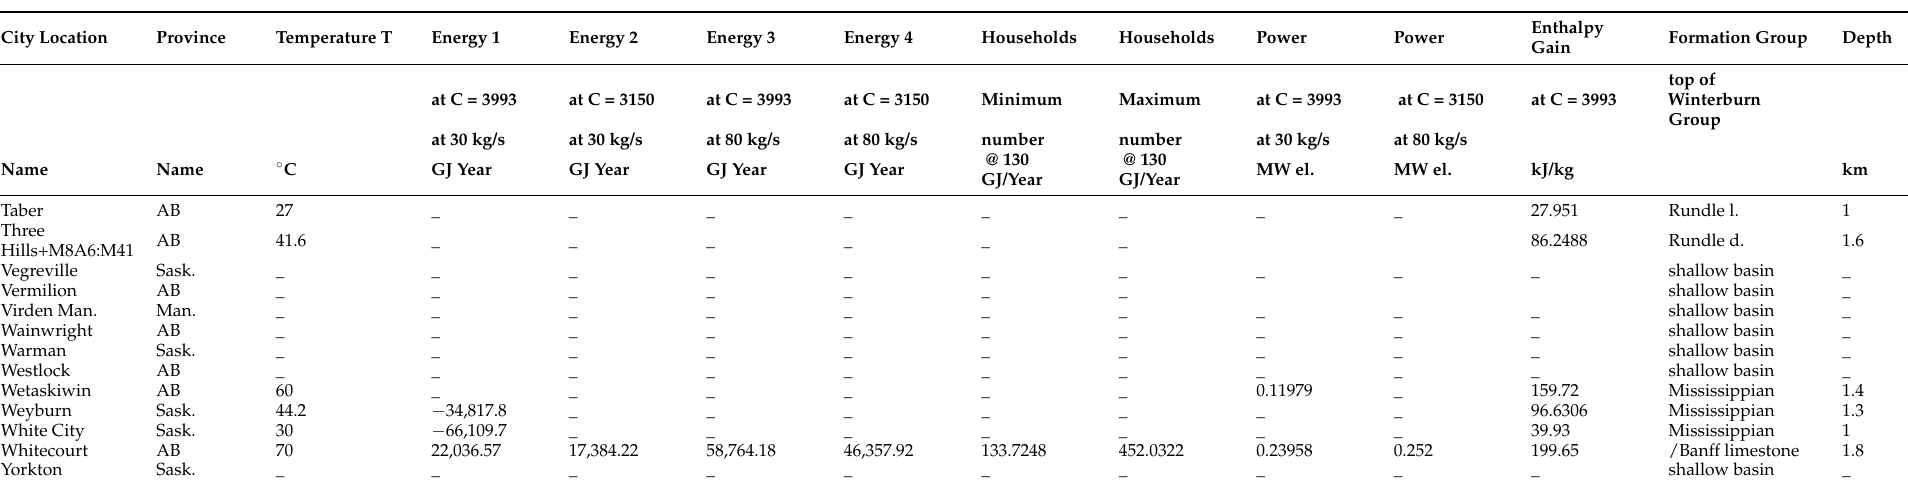
Table A5. WCSB >3 k populations centers geothermal prospects summary—Lower Cretaceous—Energy, Enthalpy, Power, Number of direct deep geothermal energy heated households feasible.